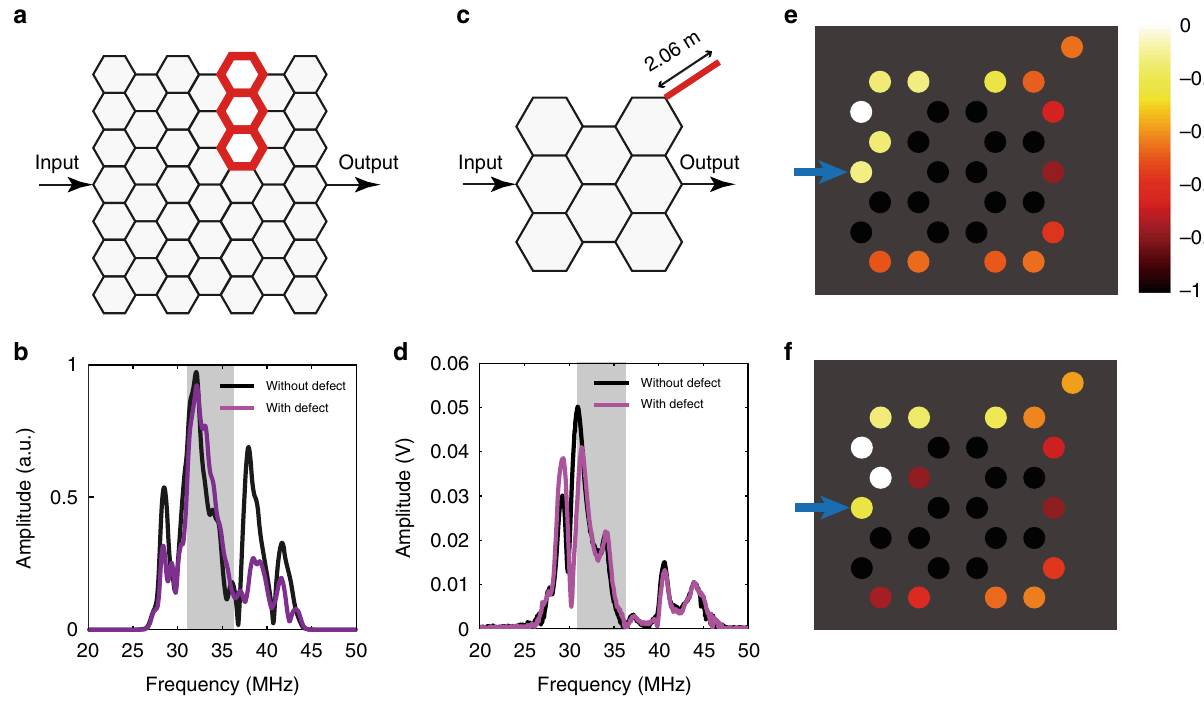
Fig. 5 Transmission spectra and edge state fi eld distributions. a The 7 × 7 network with a defect made by removing all the interlayer cables in the unit cells highlighted in red. b The simulated transmission spectra of m = 1 show that the defect disturbs the bulk transmission outside the gap region, but almost does not change the transmission inside the nontrivial gap region (gray zone). c The schematics of the experimental setup for measuring the transmission spectra of m = 1 states (with a defect as represented by the red line). d The defect does not change the transmission spectra inside the nontrivial gap range (gray zone). e , f Experimentally measured ( e ) and numerically calculated ( f ) fi eld patterns at 34.5 MHz in the nontrivial gap frequency range for m = 1. The signal enters from the point marked by the blue arrow. The color of each node represents the value of ln| U / U max |, where U is the voltage at each node, and U max is the maximum voltage among all nodes. The edge mode passes over corners and through the defect without backward scattering. The amplitude of the edge state decreases gradually due to the intrinsic loss in the cables